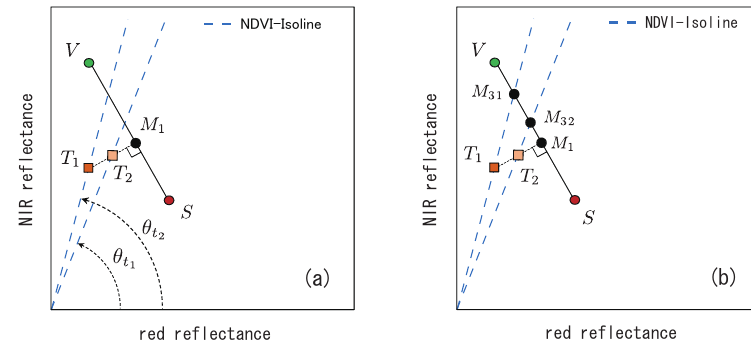
Figure 2 . The relationship between the algorithm-1 and the other two in red-NIR reflectance space. (a) Relationship between algorithm-1 and algorithm-2, (b) algorithm-1 and algorithm-3. V and S represent endmember spectrum of vegetation and non-vegetation surface. T and T are target spectra. M is a modeled spectrum by algorithm-1 for two 1 2 1 measured spectra denoted by T and T . M and M are modeled spectra by algorithm-3 1 2 31 32 for T and T , 1 2